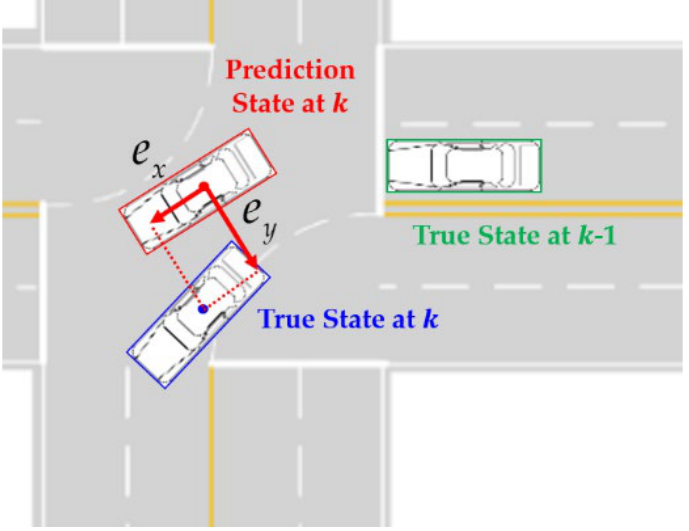
Figure 8. Basic concepts of recursive covariance estimator-based prediction uncertainty estimation. The recursive covariance estimator assumes that the measurement noise is